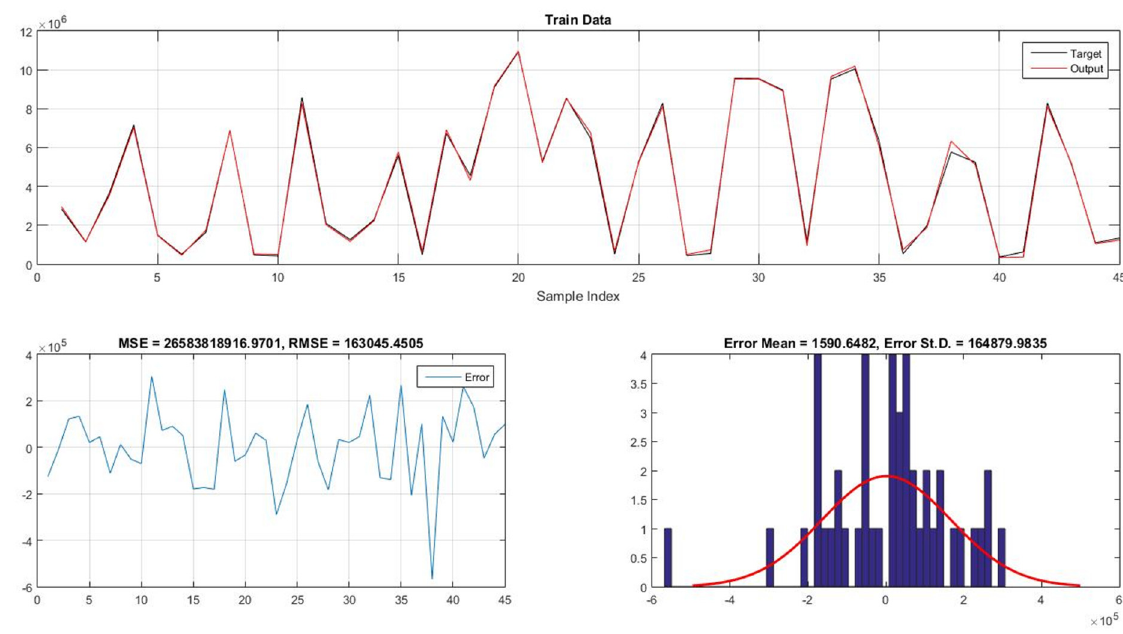
Figure 9. The ANFIS-PSO model showing the training of the traffic dataset.